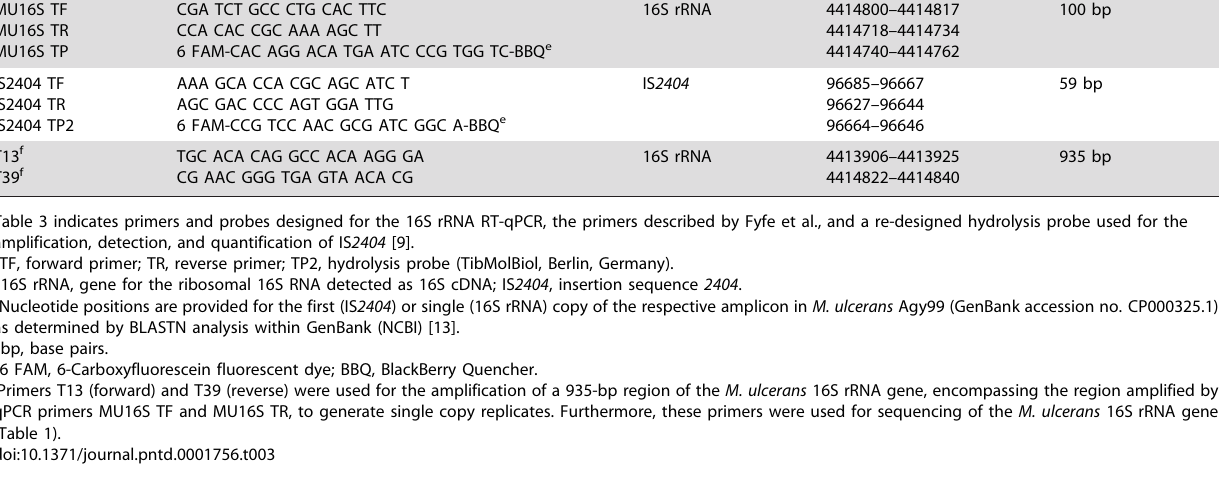
PLOS Neglected Tropical Diseases |